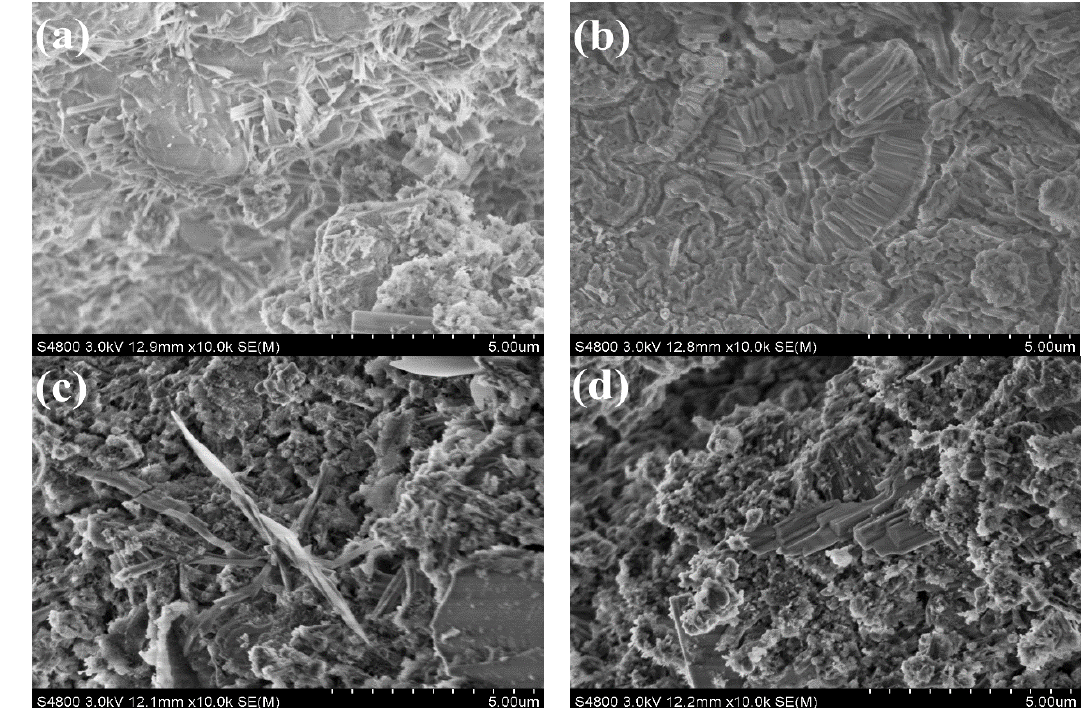
Figure 7. SEM images of CSA pastes with superplasticizers for 2 h ( a ) BNS-0.8%, ( b ) BNS-2.0%, ( c ) PC-0.08%, ( d ) PC-0.20%. Hence, in order to further know whether the addition of superplasticizer caused changes in hydrates morphology or not, Ettringite hydrated by C 4 A 3 S with maximum and minimum dosage of BNS and PC superplasticizer at 2 h were studied by SEM and the results are shown in Figure 8.